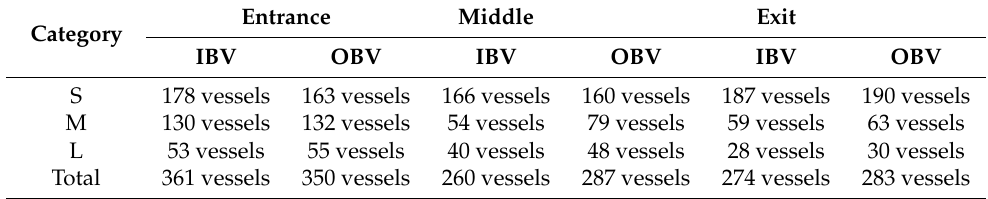
Table 1. Vessel access status in Busan North Port during the survey period (Unit : number).